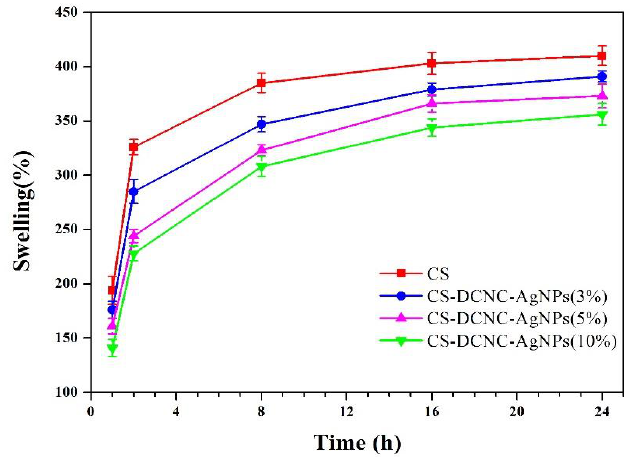
Figure 3. Swelling ratio of CS with varying DCNC-AgNPs concentration.